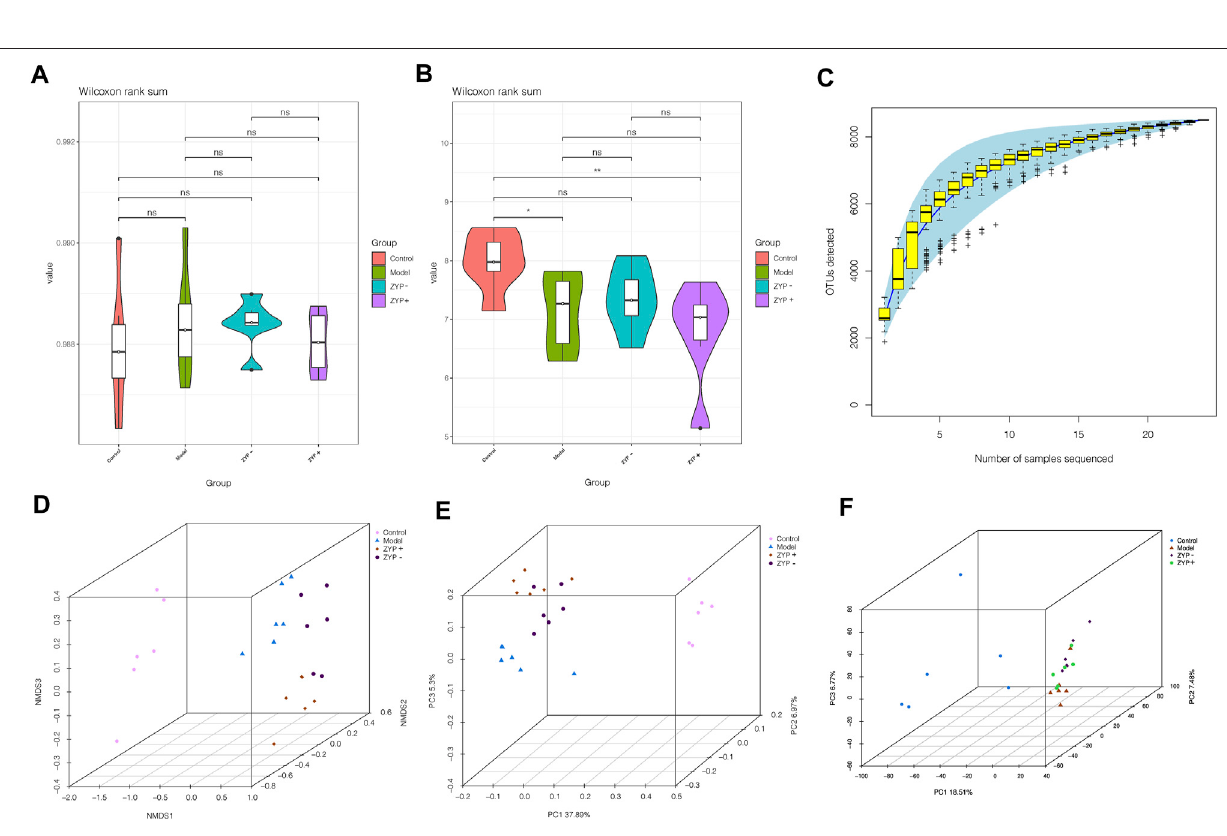
Frontiers in Pharmacology |